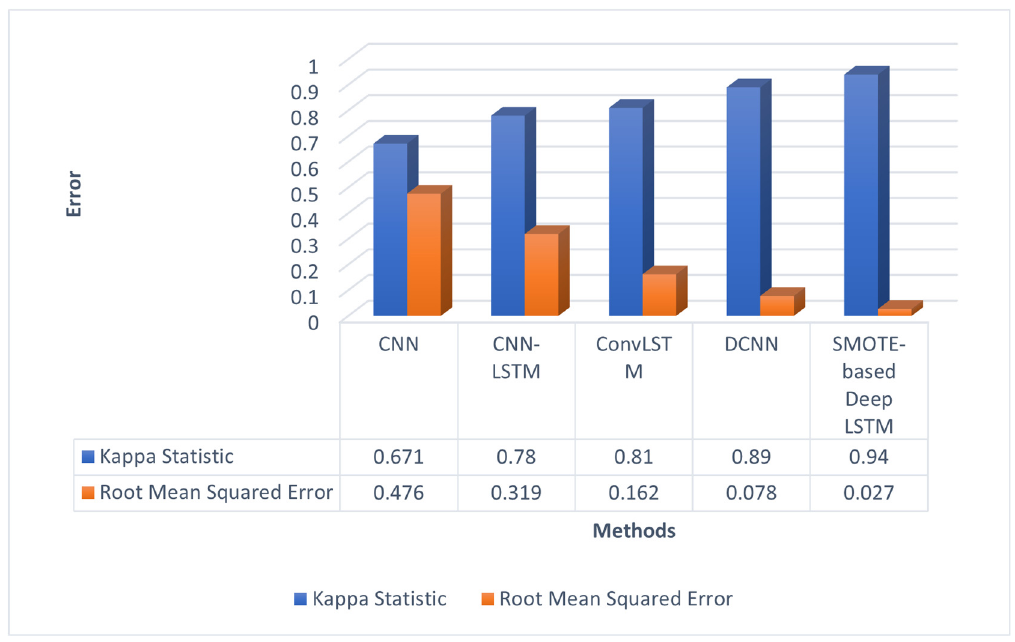
Figure 4. Errors of different deep-learning models.